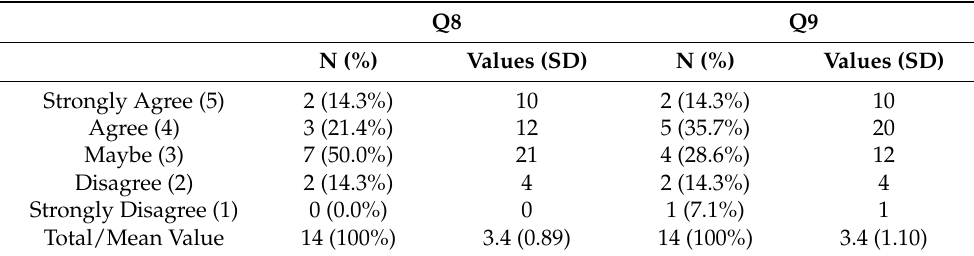
Table 5. Respondents’ Perceptions: are water shortages due to tourism activity in Mykonos (Q8), and does short-term-based water resources management exist in Mykonos (Q9)? Q8 Q9 N (%) Values (SD) N (%) Values (SD)